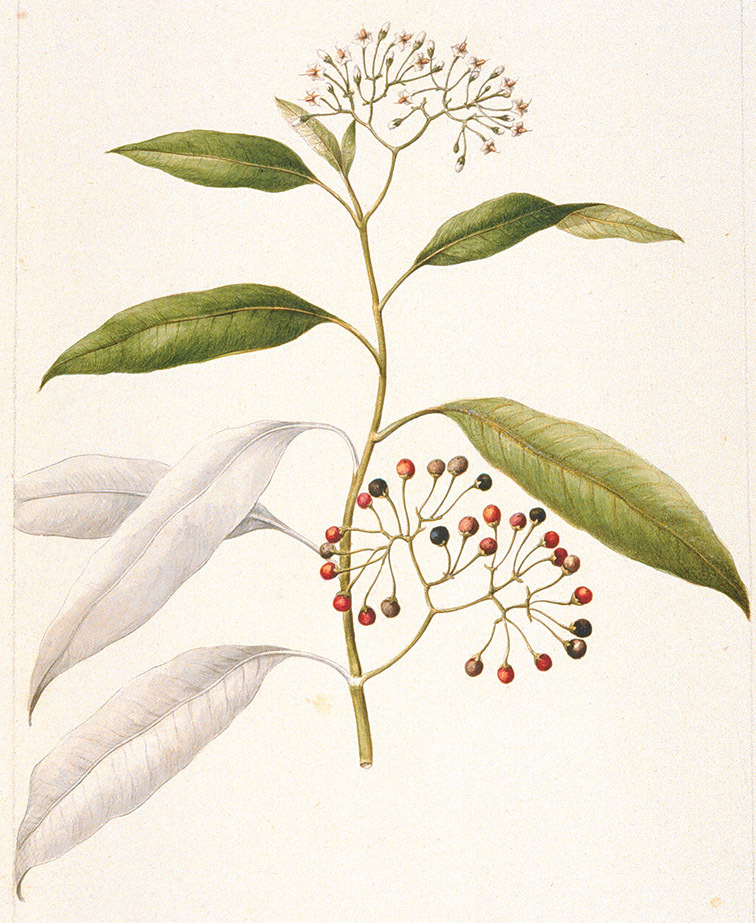
Lectotype of Solanum leptanthum Dunal (Torner Collection plate 6331.0673). Reproduced with permission of the Hunt Institute for Botanical Documentation, Carnegie Mellon University, Pittsburgh, PA. Torner Collection of Sessé and Mociño Biological Illustrations. Rights reserved.